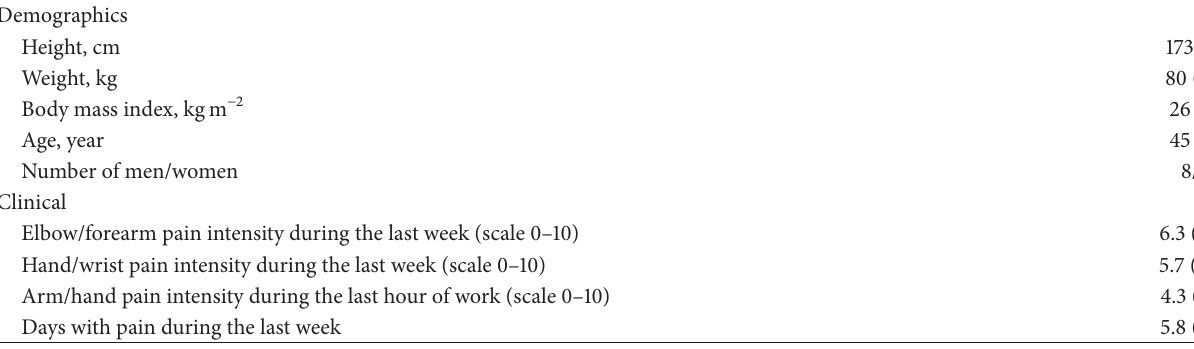
Table 1: Baseline characteristics of the participants. Values are means (SD).